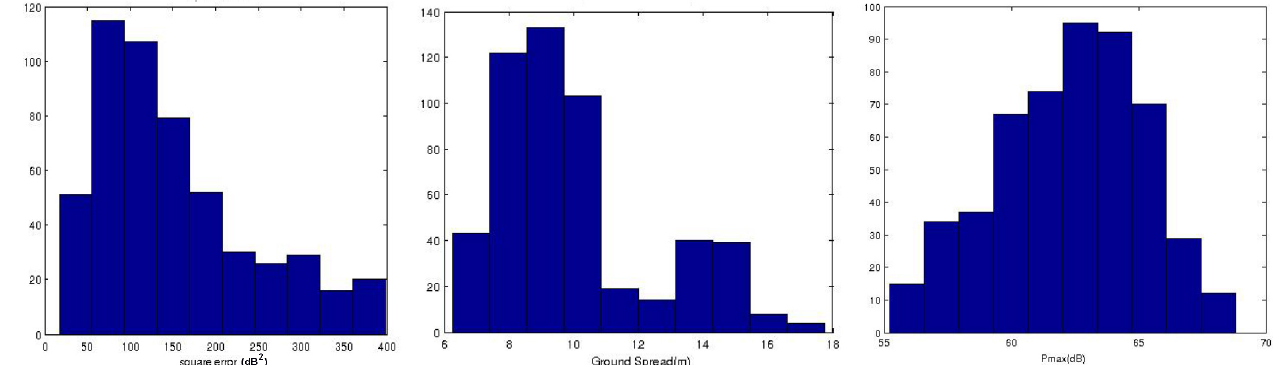
Figure 8. Histogram of the ground model features in the training set: squared error ( Left ), range spread ( Center ), maximum intensity ( Right